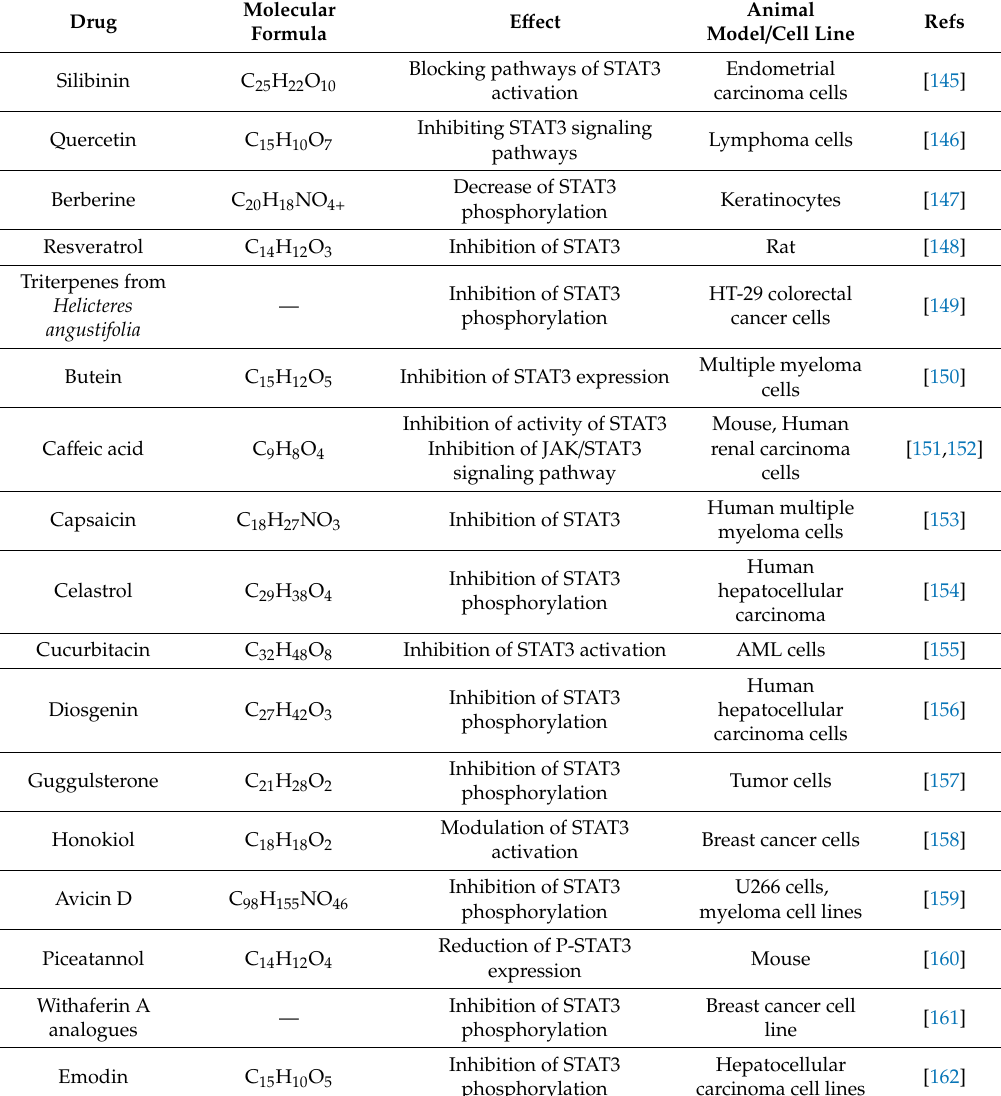
Table 2. Natural STAT3